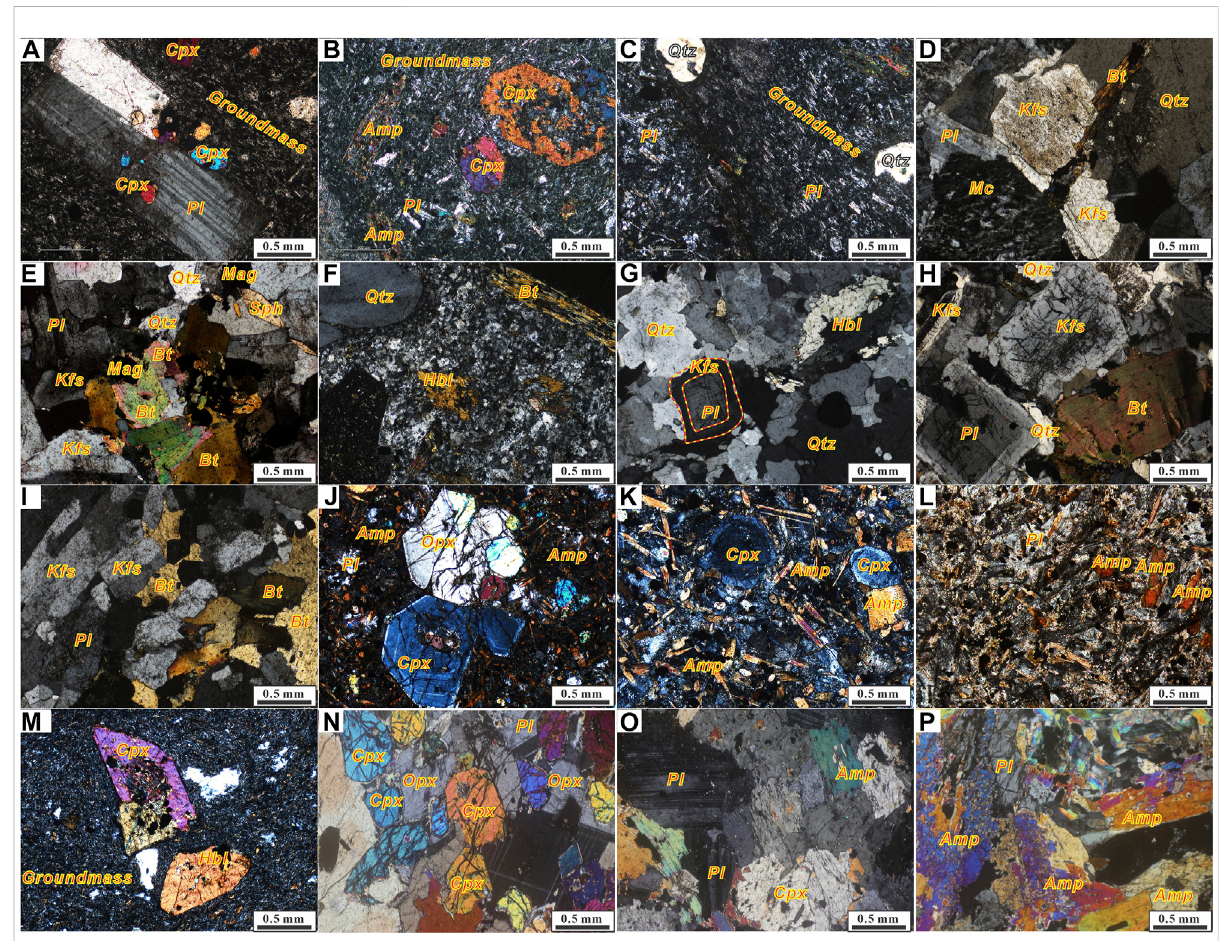
FIGURE 3 Representative photomicrographs of the Laiyuan magmatic rocks. (A – C) Andesite, dacite and rhyolite from the Laiyuan complex. (D) Syenogranite. (E) Biotitemonzogranite. (F) Porphyriticmonzogranite. (G) Rapakivihornblendemonzogranite. (H) Quartzmonzoniteshowingzoning K-feldspar and plagioclase. (I) Monzonite (J,K) Lamprophyre containing clinopyroxene and orthopyroxene minerals of zoning texture and strip amphibole minerals (L) Dolerite (M) Diorite porphyry containingclinopyroxene and hornblende phenocrysts (N,O )Pyroxenite and gabbro from the Longmengou intrusions (P) Hornblendite from the Yaogou intrusions. Mineral abbreviations: Amp-amphibole; Ap-apatite; Bt-biotite; Cpx- clinopyroxene; Cal-calcite; Hbl-hornblende; Kfs-K-feldspar; Mag-magnetite;Mc-Microcline; Ol-olivine; Opx-Orthopyroxene; Pl-plagioclase; Qtz- quartz;